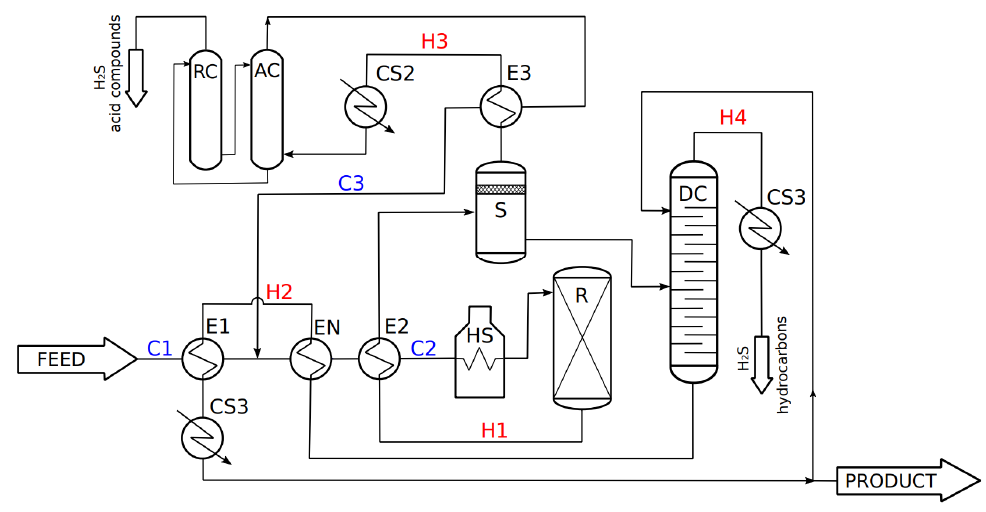
Figure 8. The modified process scheme with the inserted new heat exchanger (EN).